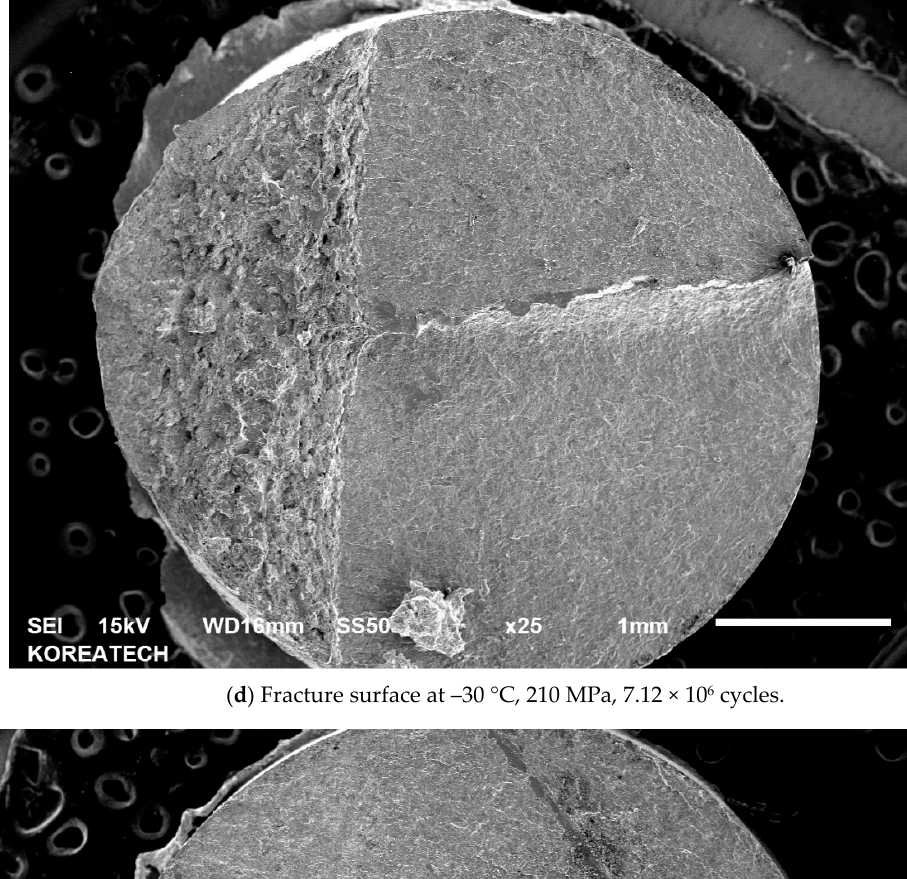
Figure 7. S–N diagram and fracture surface at –30 °C.